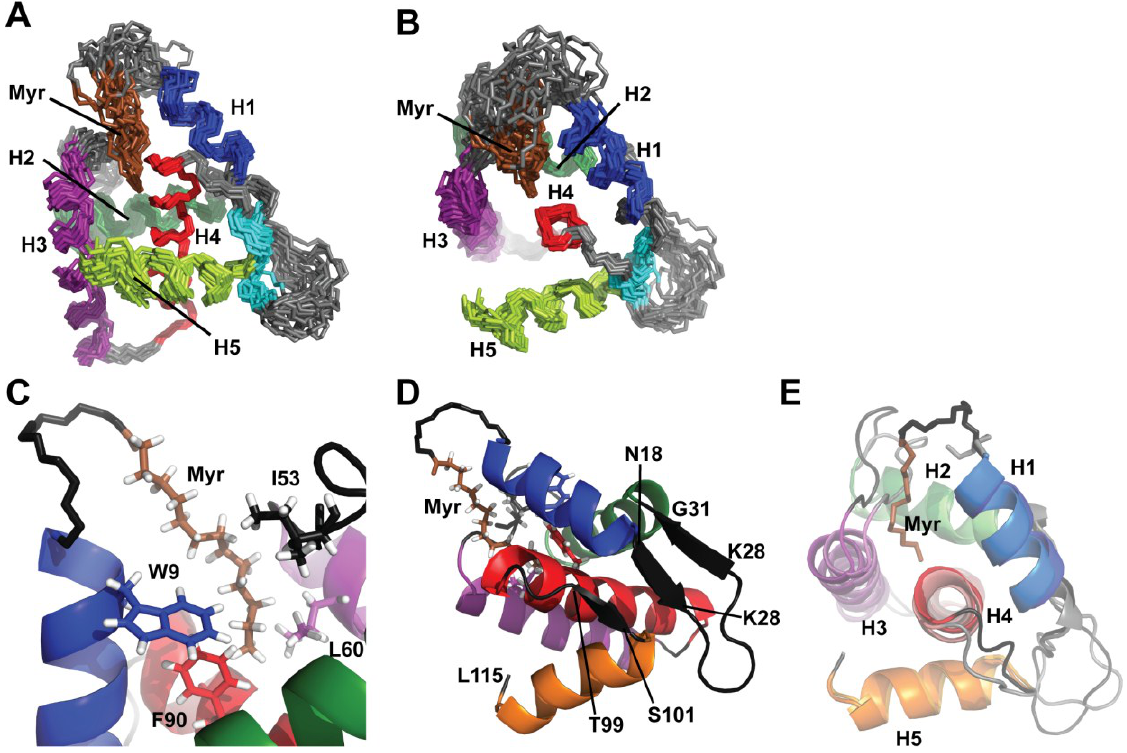
Figure 4. ( A , B ) Views of the NMR ensemble (20 structures, generated by superposition of backbone atoms of refined residues) showing the relative orientation of helices and position of the myristyl group; ( C , D ) Representative NMR structure showing ( C ) the packing of the myristyl group with the side chains of buried hydrophobic residues; and ( D ) relative position and orientation of the three-strand pseudo-β-sheet; ( E ) Comparison of a representative myrMA Q5A/G6S NMR structure with the X-ray crystal structure of